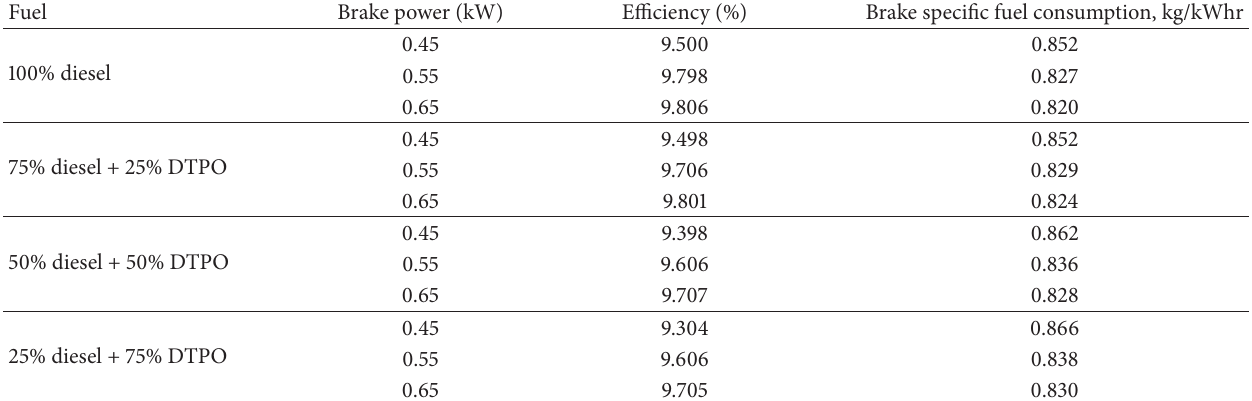
Table 5: Performance results for different blended fuels.